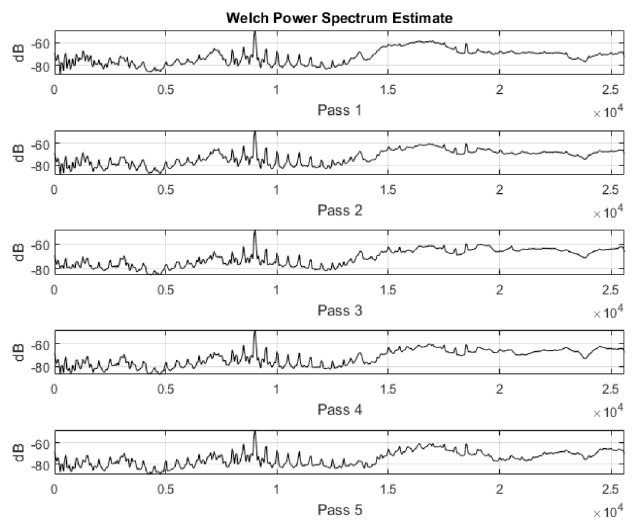
Figure 12. Welch’s power spectrum estimate for each pass/cycle.